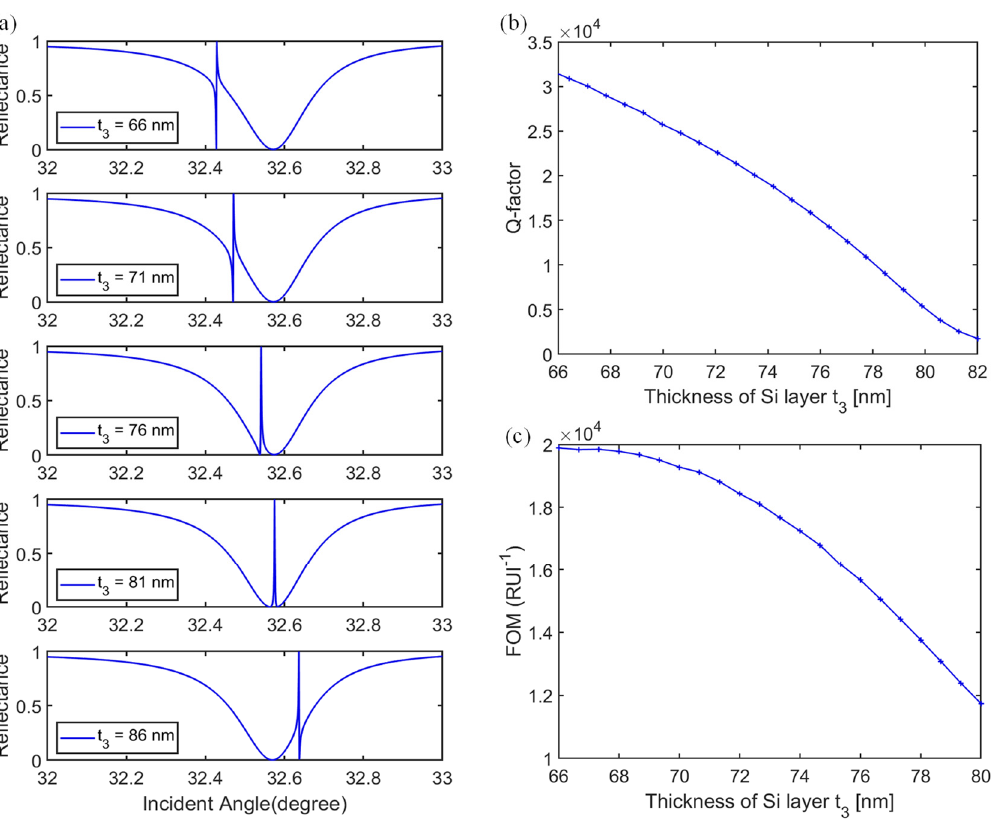
Figure 11. ( a ) The movement of the Fano resonance dip, ( b ) variation of Q-factor, and ( c ) FOM with Si thickness increased from 66 nm to 86 nm.